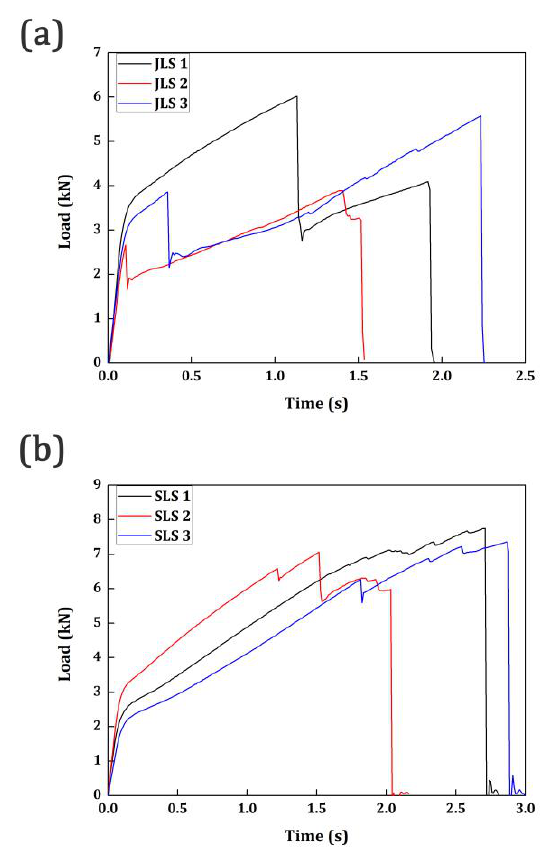
Figure 4. Load vs. time curve: ( a ) JLS Specimens; ( b ) SLS Specimens.